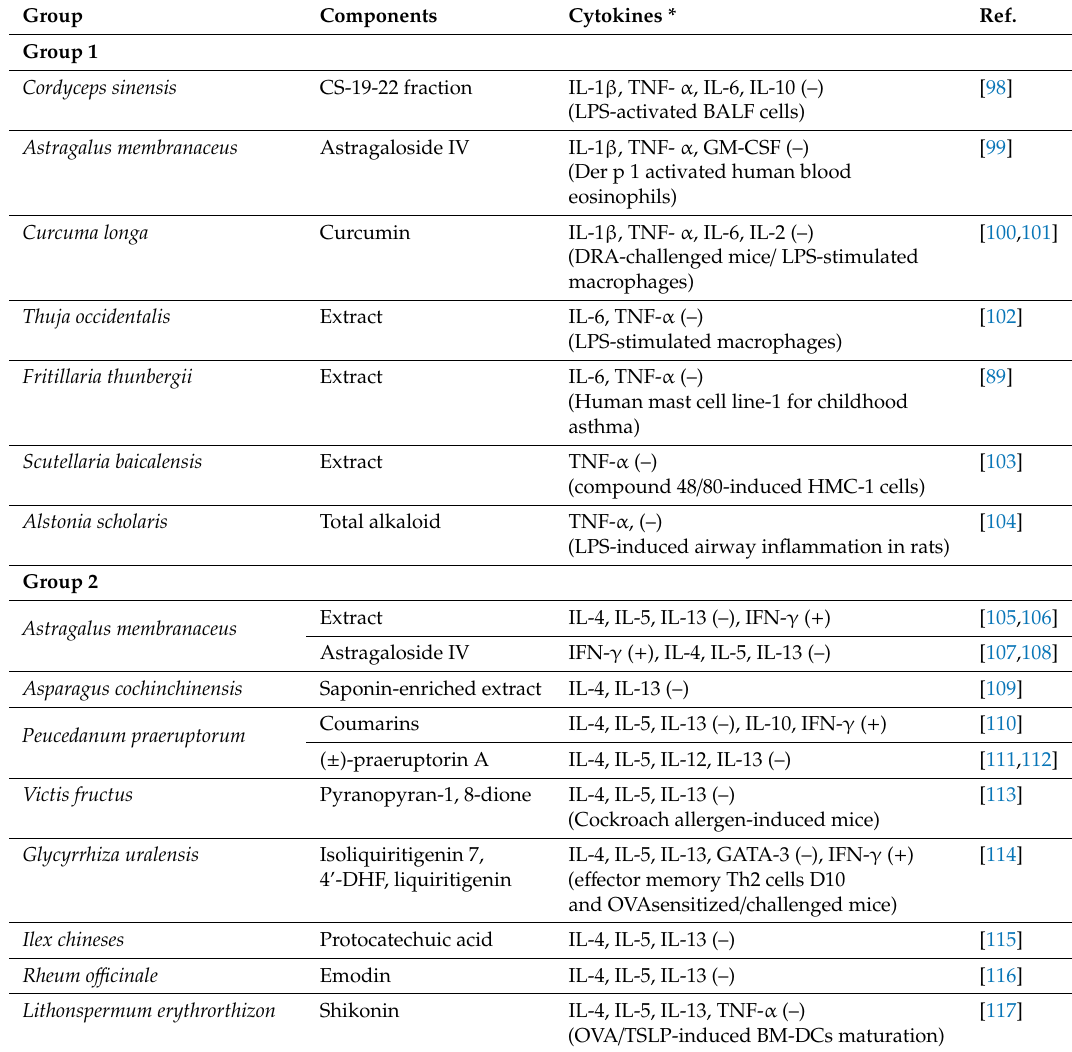
Table 2. Relationship of cytokines with single herb and components. GM-CSF: